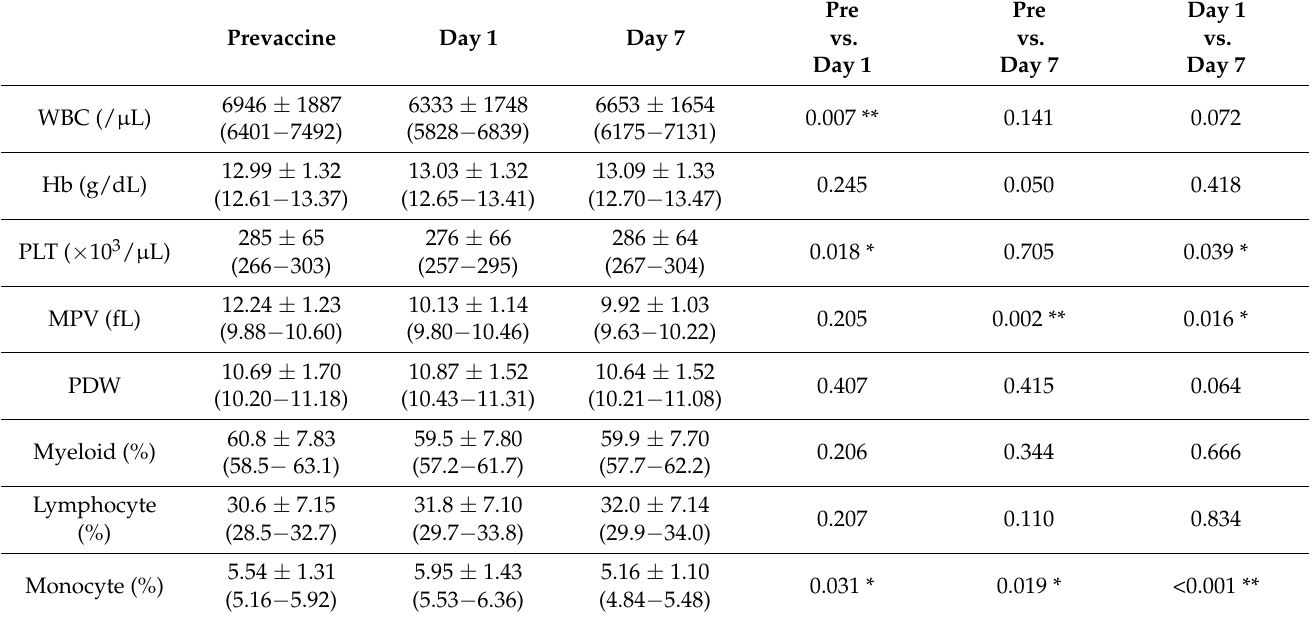
Table 1. The demographic and laboratory characteristics of the 48 donors before and after ChAdOx1 nCoV-19